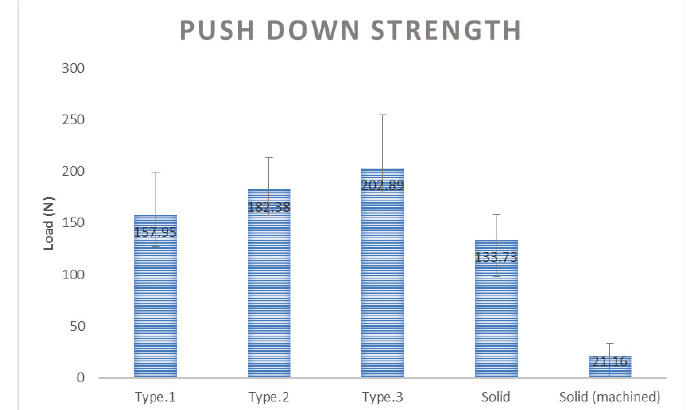
Figure 7. Comparison of push down strength result by sample type.